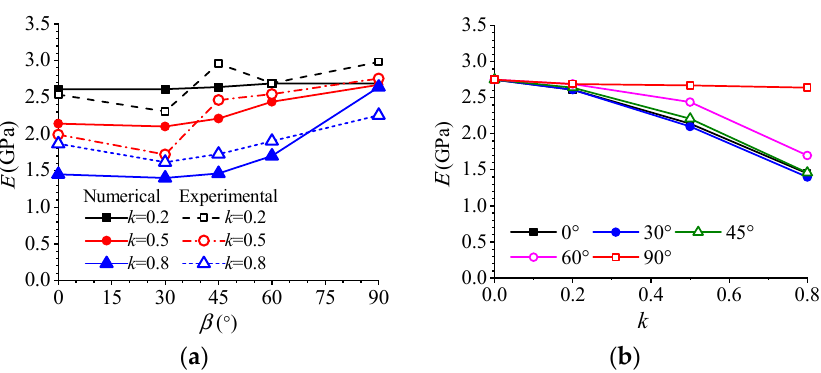
Figure 18. Young’s modulus vs. the two geometrical parameters by numerical simulation. ( a ) E vs. β ; ( b ) E vs. k .